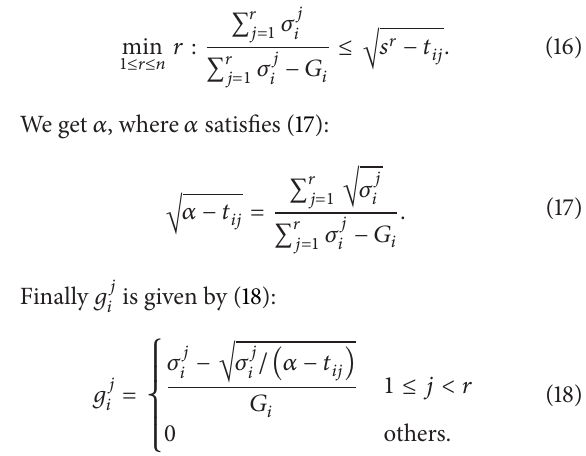
Algorithm for noncooperative game among users: (see Algorithm